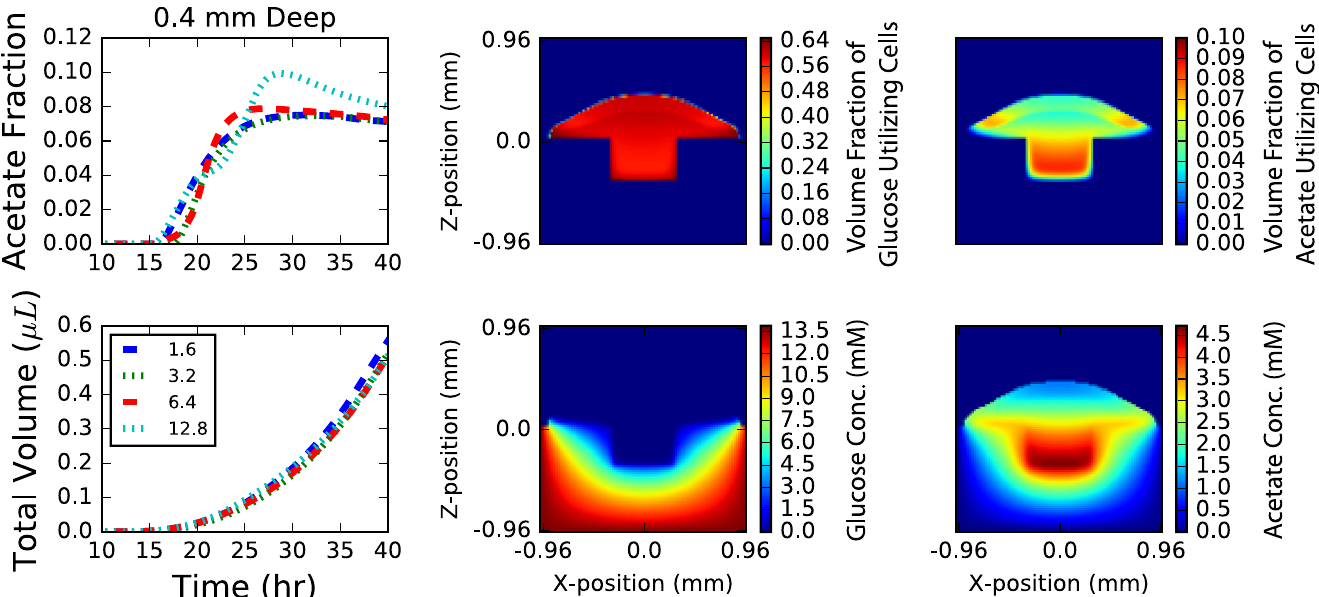
Fig 9. Hole geometry. Results for coloniesgrown at the bottom of a square hole in an agar surface 0.4 mm deep. Results for holes 0.2 mm deep are not shown as they are similar. The colony growth (top left) is mildly dependentupon the width of the hole with wider holes growingslightly more quickly. The relative fraction of acetate (bottom left) utilizersin the populationgrow with time until the wall the colony reachesthe wall and a burst of glucoseutilizersare grown until the colony on the wall is thick enoughto begin producing acetate utilizers once again. The confinement leads to larger fraction of acetate utilizers than seen on flat surfaces. Snapshots of populationvolume fractions (top middle and right) and chemicalconcentrations (top middle and right) after 40 hours of growth. Further, a large build-upin acetate concentration (bottom middle;units of mM) insidethe hole is apparentwhilenothing interestingoccurs with the glucoseconcentration (bottom right; units of